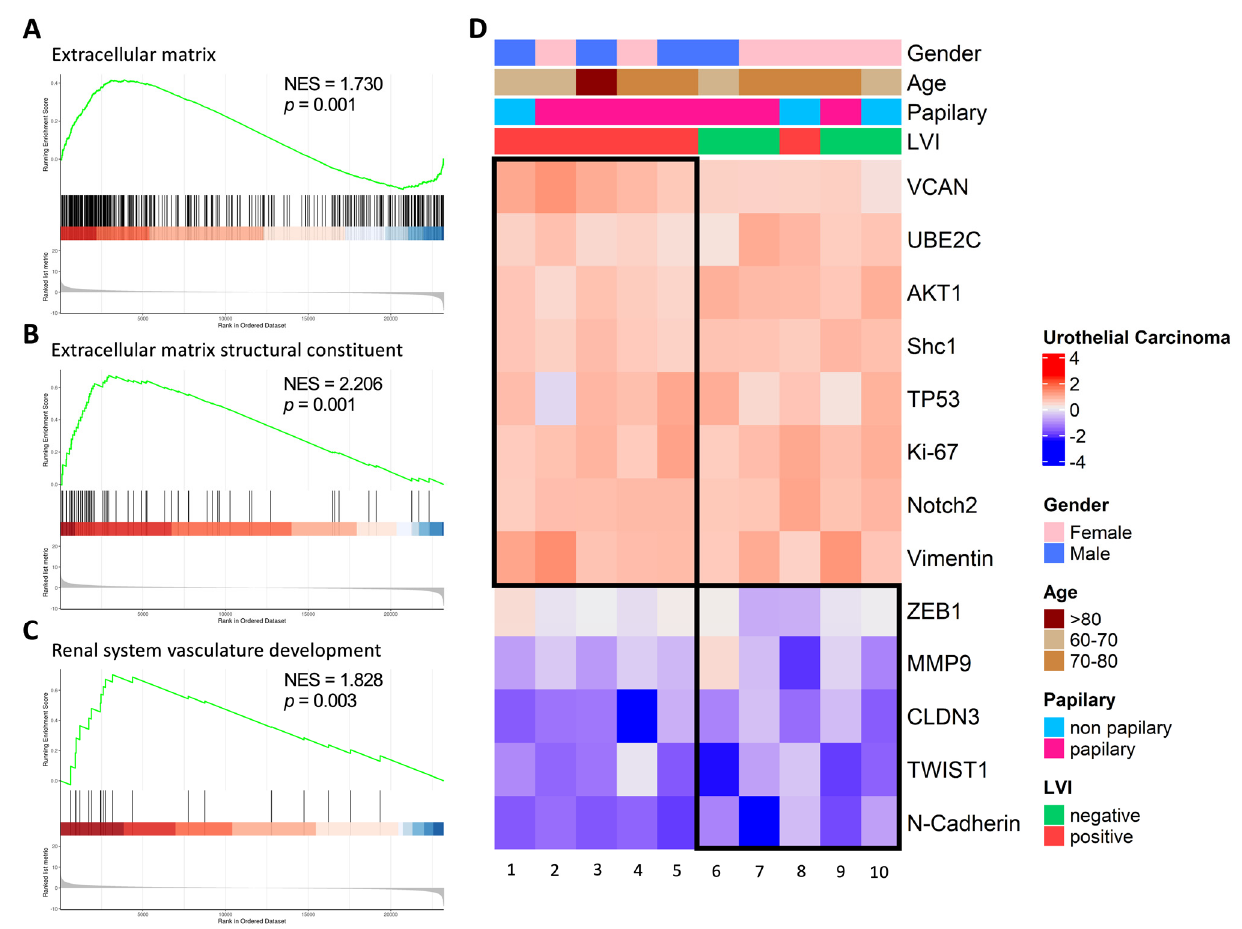
Figure 6. Analysis of the correlation between VCAN expression and molecular subtypes in UTUC. mRNA expression of molecular subtypes was analyzed based on the level of VCAN expression. ( A – C ) mRNA expression in ten patients with stage III UTUC tumors showed correlation with extracellular matrix organization, collagen-containing extracellular matrix and extracellular matrix structural constituents. ( D ) Gene clustering for migration biomarkers.